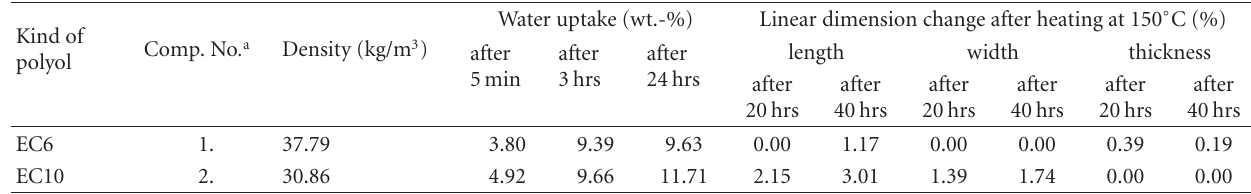
Table 5: Properties of foams.